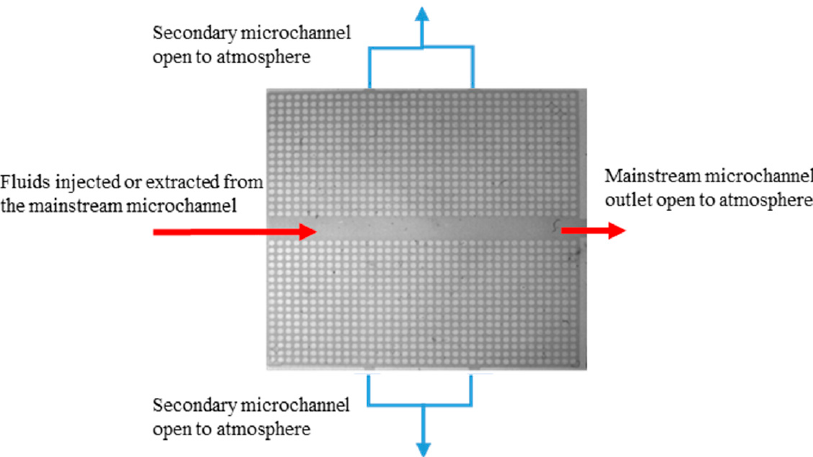
Figure 4. The inlet and outlets of the micromodel. The fluids are injected or extracted from the left inlet of the mainstream microchannel, which provides a constant-flow-rate boundary condition. The five outlets are connected to atmospheric air, thereby providing constant-pressure boundary conditions. The outlet on the right end of the micromodel is directly connected to the mainstream microchannel, and the other four outlets are connected to the top and bottom of the secondary microchannels (microarrays). The direction shown in the figure is for the injection experiments, and its opposite direction is for the extraction experiments.